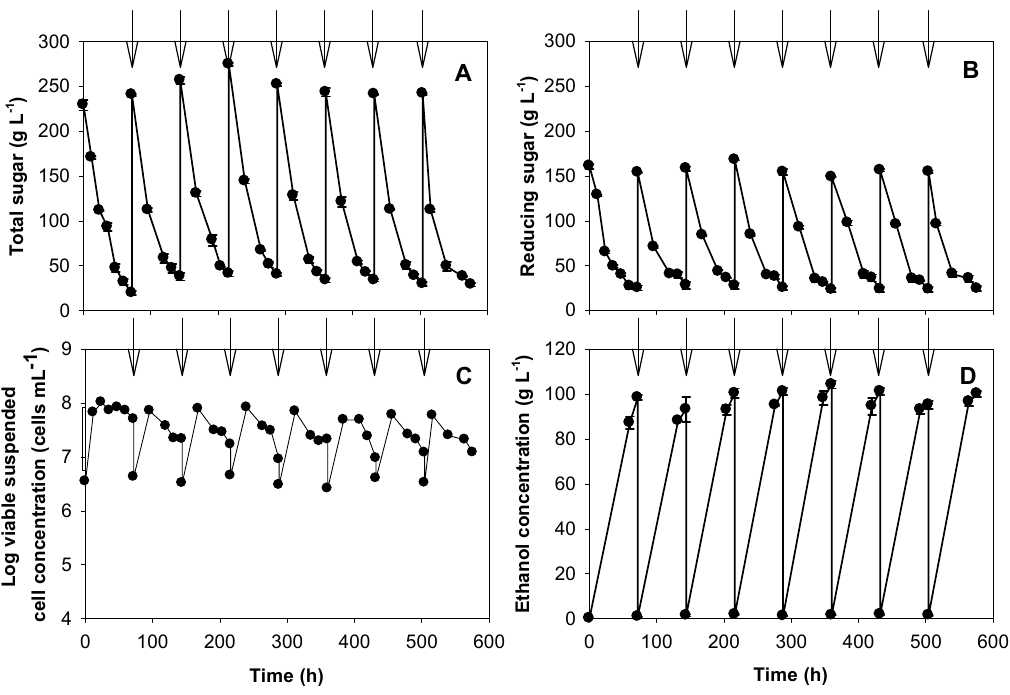
Figure 3. Repeated-batch culture profiles of ethanol production from sweet sorghum juice by S. cerevisiae NP 01 immobilized on 6 × 6 × 6 mm 3 sorghum stalks. ( A ) total sugar; ( B ) reducing sugar; ( C ) viable suspended cell concentration; and ( D ) ethanol concentration. The arrows indicate the start time of each